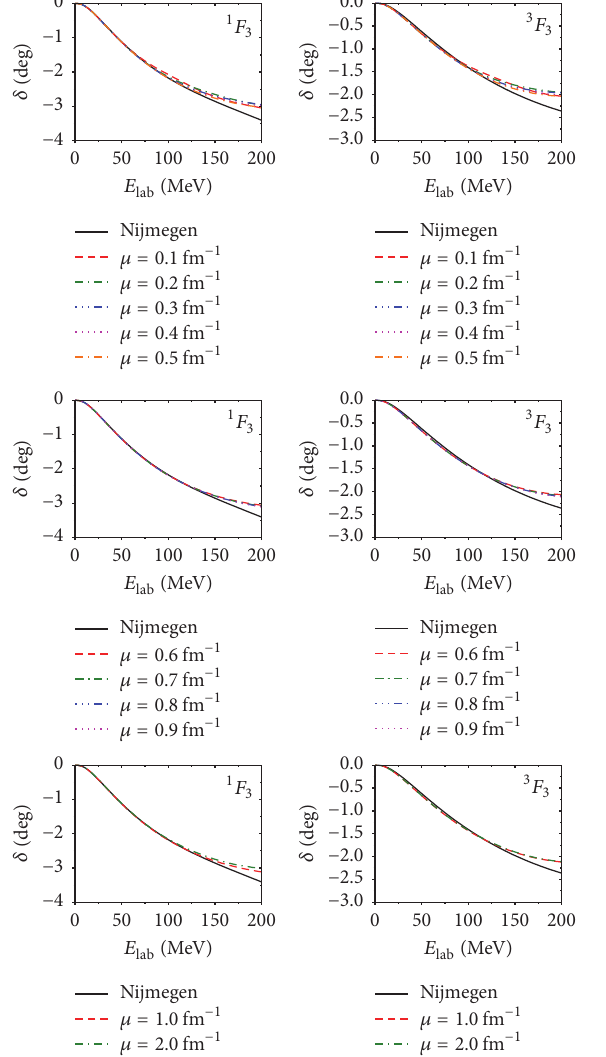
Figure 8: (Color on-line) phase shifts in 1 𝐺 4 and 3 𝐺 4 channels calculated from the solution of the subtracted LS equation for the 𝐾 -matrix with five subtractions for the N3LO-EGM potential for several values of the renormalization scale compared to the Nijmegen partial wave